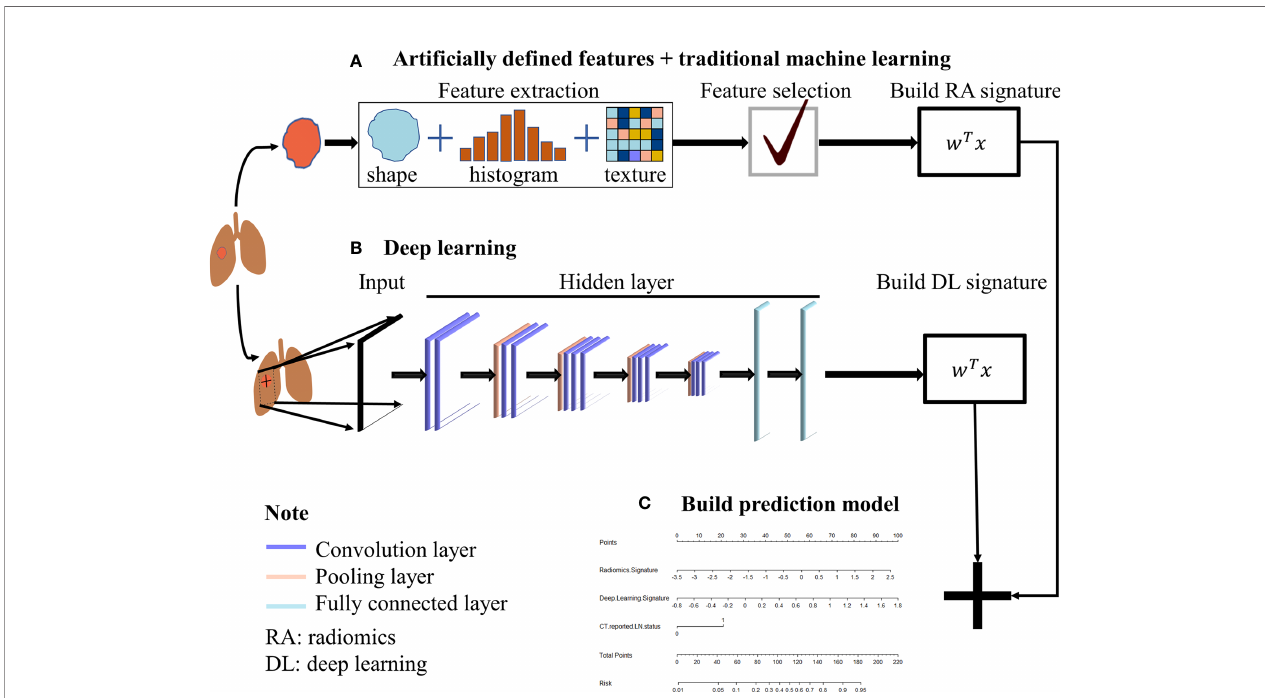
FIGURE 1 | The work fl ow. (A) Traditional radiomics was used to extract arti fi cial pre-de fi ned features from the ROI region, and then the extracted features were selected and weighted to obtain the radiomics signature. (B) CNN was used to extract the automatic learning features from the slice where the ROI was located and then weighted to obtain deep learning signature. (C) Radiomics signature and deep learning signature were used to build the prediction